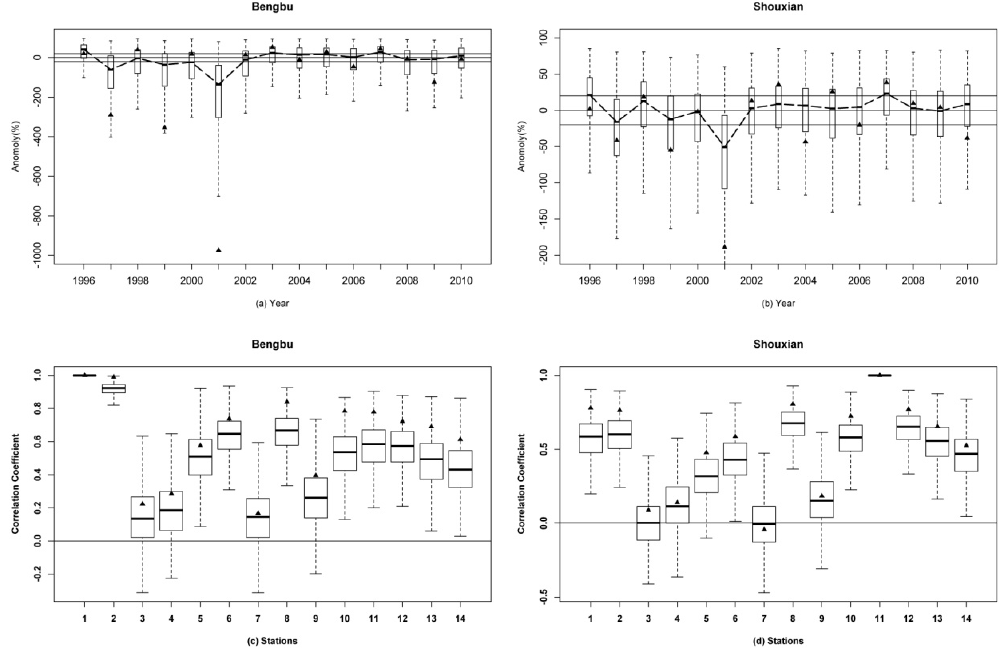
Fig. 5. The posterior probability distributions for JJA averaged streamflow and JJA total rainfall for (a) standardized streamflow at Bengbu station and (b) standardized rainfall at Shouxian station. The posterior distribution of the cross-site correlation for Bengbu station and for Shouxian station is presented in (c) and (d) , respectively. Each box plot has the 25th, median and 75th percentile of the posterior distribution, with whiskers extended to the extreme values sampled. The solid triangle denotes the observation.